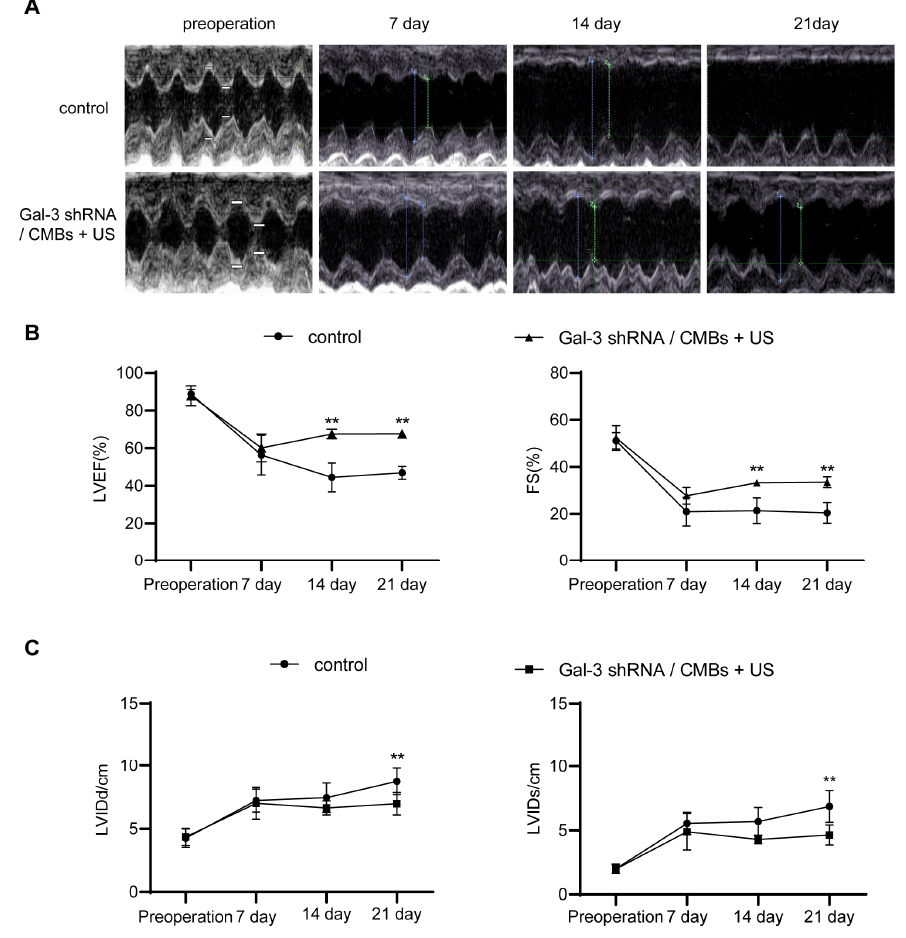
Figure 4. The improvement in cardiac function in MI rats. ( A ) Representative M-mode echocardio- graphy images. The symbol showed the measurement of cardiac function. ( B , C ) Cardiac function indicators of LVEF, FS, LVIDd and LVIDs were evaluated accordingly. ( n = 3, ** p < 0.01).